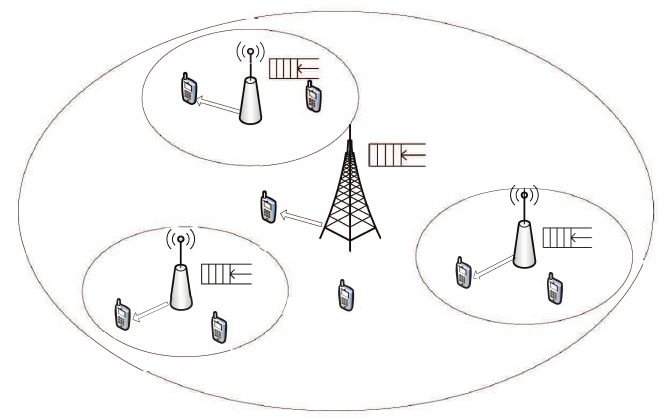
Figure 1. A two-tier heterogeneous network with spatiotemporal